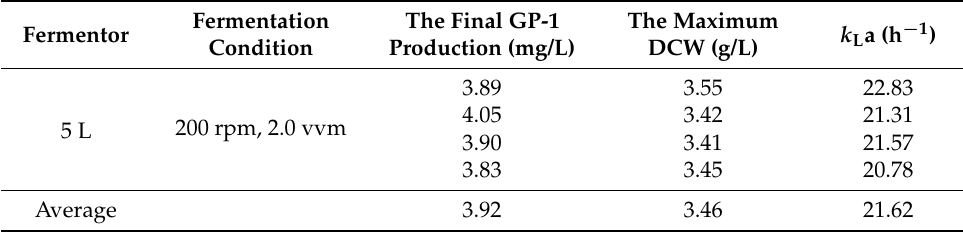
Table 2. The final GP-1 production, the maximum DCW and k L a in 5 L